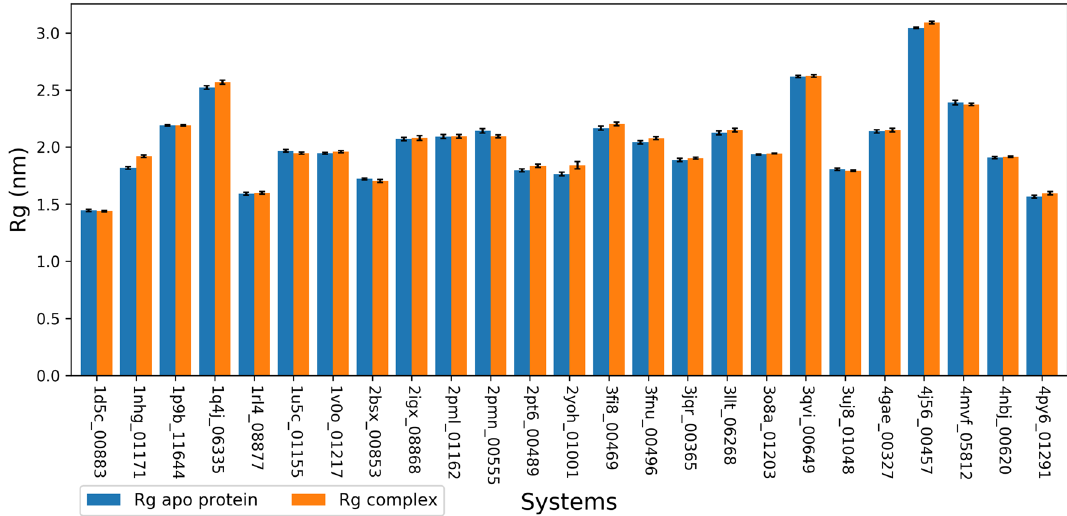
Figure 4. Calculated mean of Rg of the backbone atoms for apo and complexes during the 20 ns simulation. Protein–Ligand systems are represented by their PDB IDs and DrugBank IDs (last five digits). Error bars represent the standard deviation of the means (σ). Color code: orange: complexes; blue: apo Thioredoxin reductase (PfTrxR, PDB ID: 4j56)—Prazosin (DB00457) 4j56 is a thioredoxin reductase-thiore- doxin structure complexed with its substrate and the prosthetic group flavin adenine dinucleotide (FAD). The enzyme is essential for Plasmodium falciparum and is involved in redox homeostasis 32 . It was identified as a putative liver stage target 33 . The compound prazosin is a selective α -1-adrenergic receptor antagonist used to treat hypertension. In this case it binds to the FAD binding site in a completely buried pocket. It interacts with some water molecules, ALA191, ALA369, ASP357, CYS88 CYS93, GLY52, LYS96, PRO51, SER212, THR87, VAL233 (Fig. 3C and Supplementary Figure S38c). CYS93, CYS88 form the redox centers for the protein’s function 32 . Prazosin also forms hydrogen bonds with LYS96 and ASP357. The FAD binding pocket is large with a mitigated polar character, in which prazosin occupies a large portion. Its scaffold is characterized by an aromatic quina-